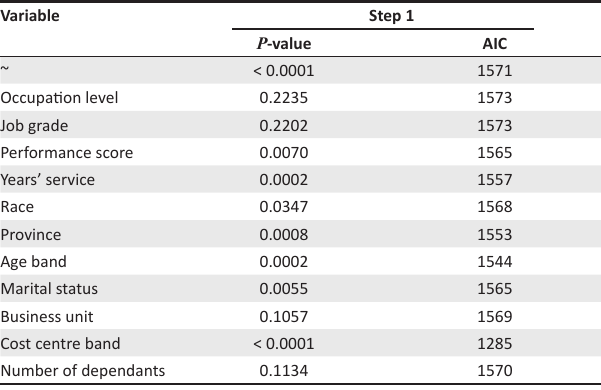
TABLE 2: Variable selection with Akaike information criterion.